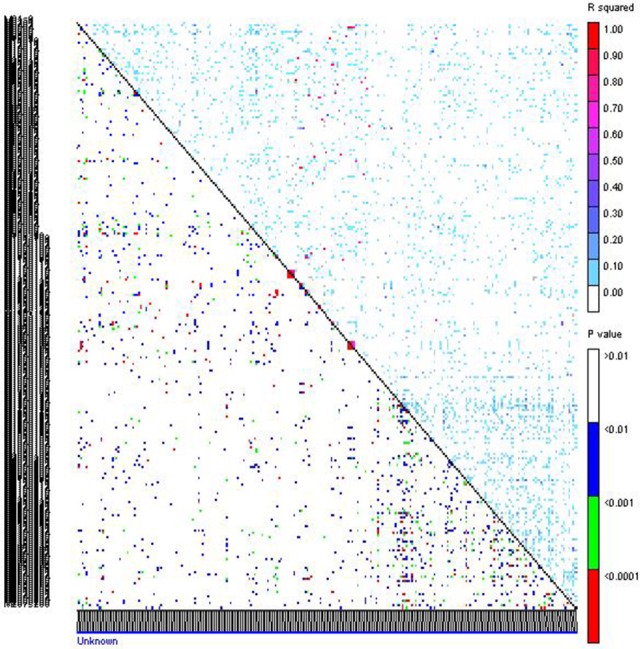
Linkage disequilibrium pattern of association mapping panel genotyped with 267 markers. Upper triangle represents R2 of markers and in lower triangle corresponding p-values are given.